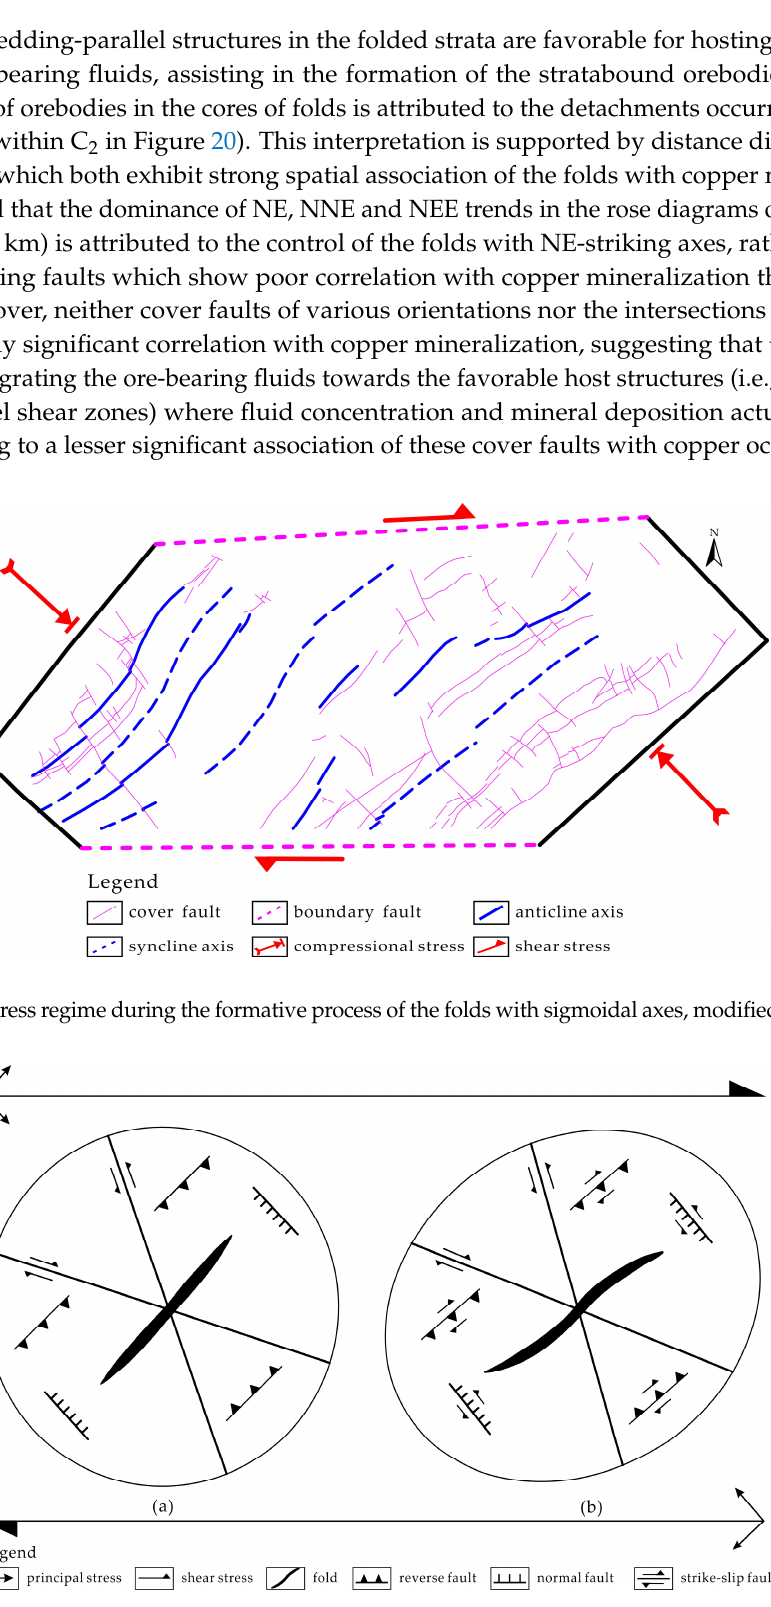
Figure 19. Deformation model of dextral shearing in a strike-slip fault zone, modified from [61]. ( a ) a structural system formed in initial stage of deformation; and ( b ) a rotation of structural elements during continued strike-slip shearing.